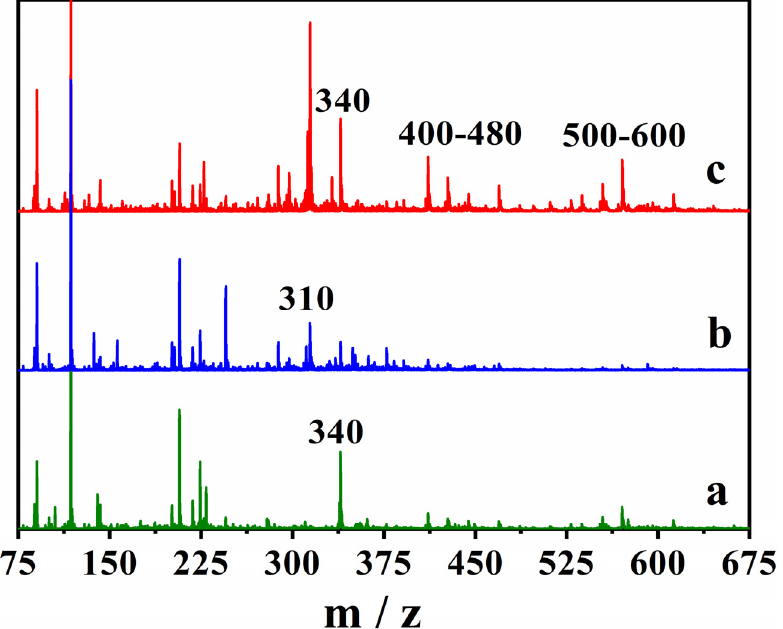
Figure 12. The positive ESI-MS spectra of ( a ) the blank cork bio-oil, ( b ) the cork bio-oil alkaline emulsion, not subjected to electrolysis, and ( c ) after Electrolysis III, a bulk electrolysis in a single- compartment cell.